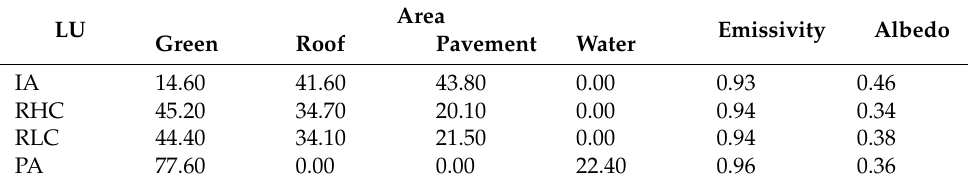
Table 3. Distribution of land cover area (%), emissivity and albedo in each